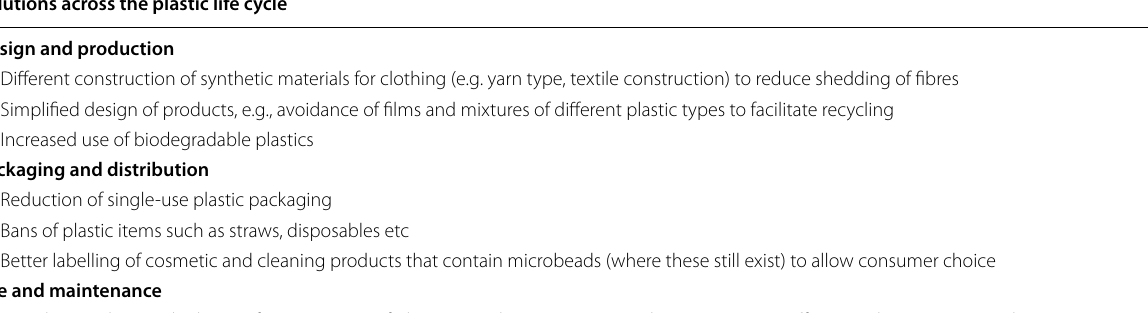
Table 3 Potential microplastics solutions across the plastic life cycle Solutions across the plastic life cycle Design and